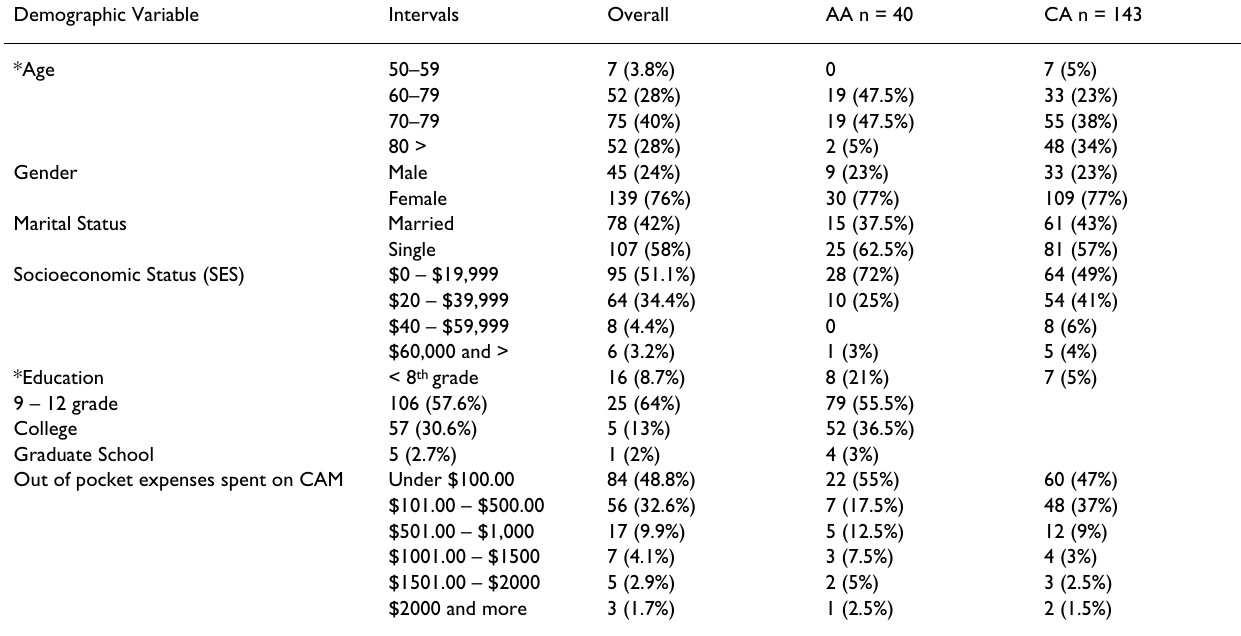
Table 1: Demographics of older adults who reported use of CAM Demographic Variable